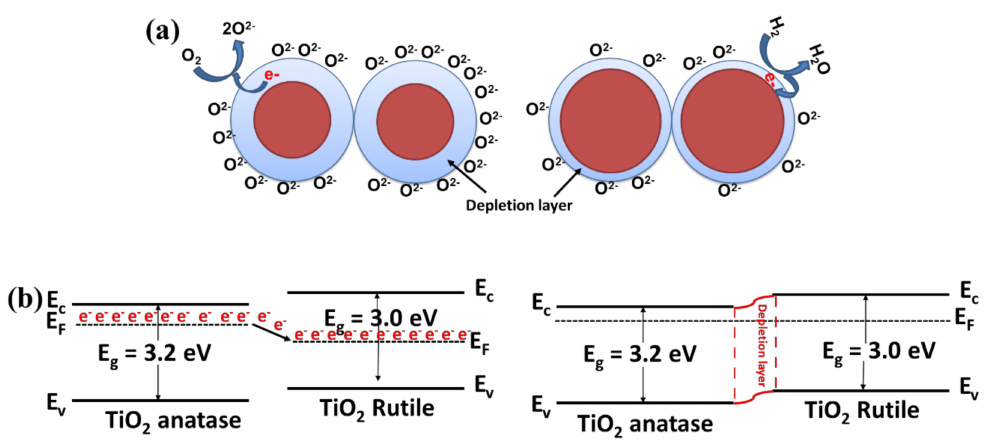
Figure 11. ( a ) An illustration of the general hydrogen sensing mechanism of TiO 2 -based sensors ( b ) energy band diagram of TiO 2 anatase and